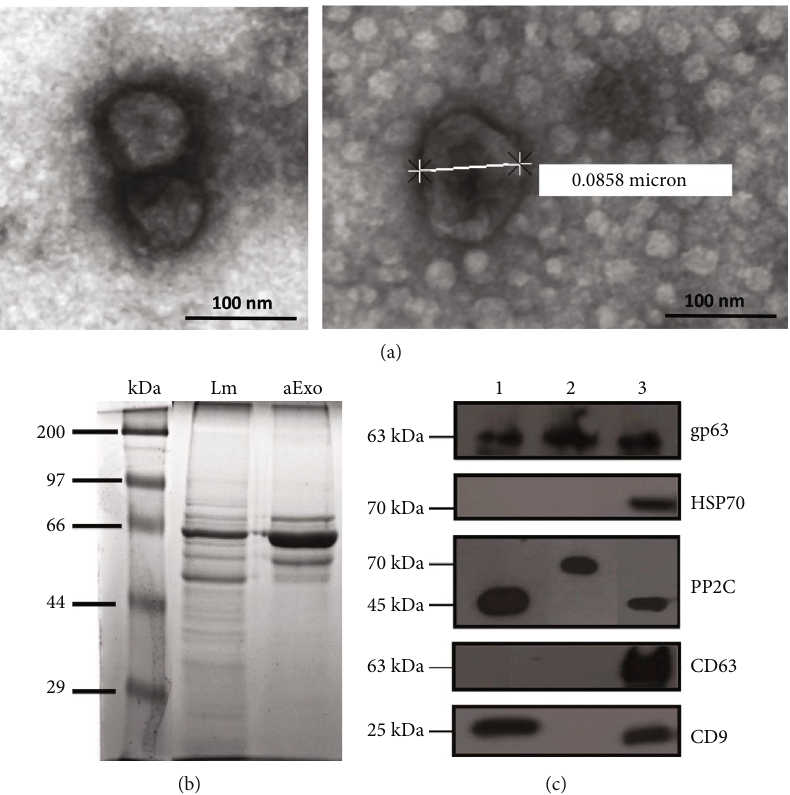
Figure 2: Exosomes released by L. mexicana amastigotes contain gp63 and PP2C. Isolated exosomes from supernatants of L. mexicana amastigote cultures were visualized by TEM and their protein pro fi le was analyzed. (a) Representative TEM micrographs of aExo with negative staining. Left image shows exosomes contained within membranes (120,000x magni fi cation). Right image exhibits aExo with a diameter of ~ 85 nm (160,000x magni fi cation). (b) Protein pro fi le of L. mexicana amastigotes lysate (Lm) and of their exosomes (aExo) in 10% SDS-PAGE with silver stain. (c) Immunodetection of gp63, HSP70, PP2C, CD63, and CD9 in lysates of L. mexicana amastigotes and their secreted exosomes. Lane 1: amastigote lysates; Lane 2: exosome lysates; Lane 3: positive controls. The images are representative of two 2 independent